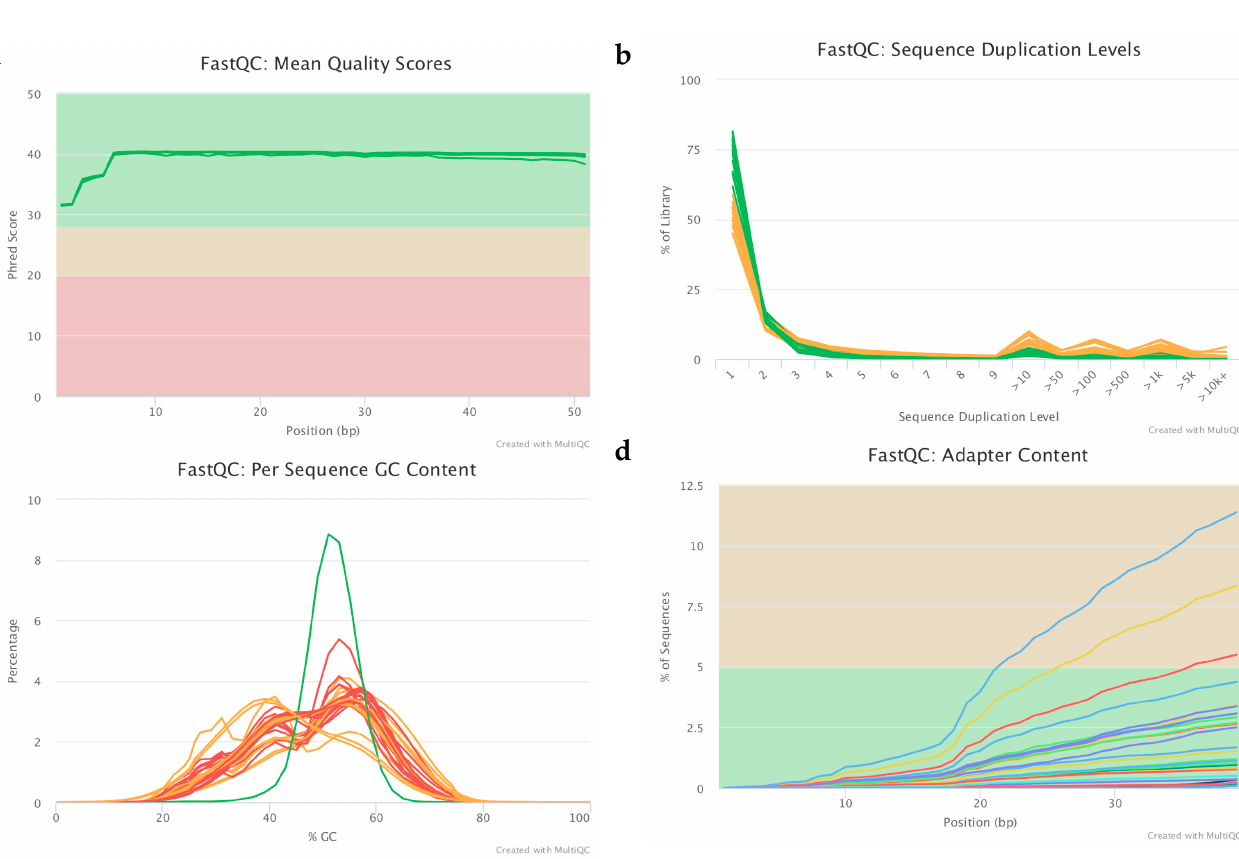
Figure 1. Representing plots from the raw data quality checking process with the following subfigures: ( a ) Sequence quality histogram, ( b ) Sequence duplication level, ( c ) Per sequence GC content, ( d ) Adapter content.